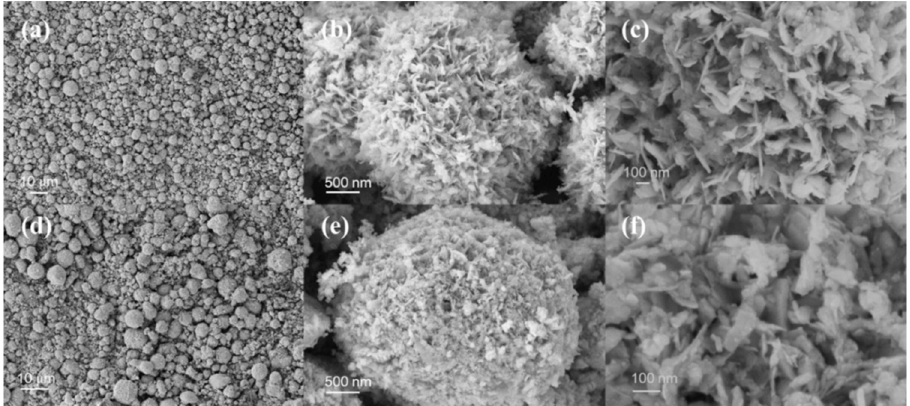
Figure 1. SEM images of ( a – c ) In 2 S 3 and ( d – f ) Pt/In 2 S 3 .